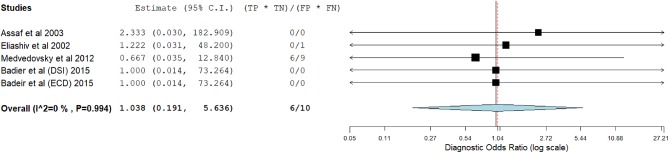
Forest plot showing diagnostic odds ratio of the IC-MSI studies (individual studies: size of the squares are proportional to weights used in meta-analysis; the summary measure: center line of the diamond; associated 95% confidence intervals: lateral tips of the squares and the diamond).